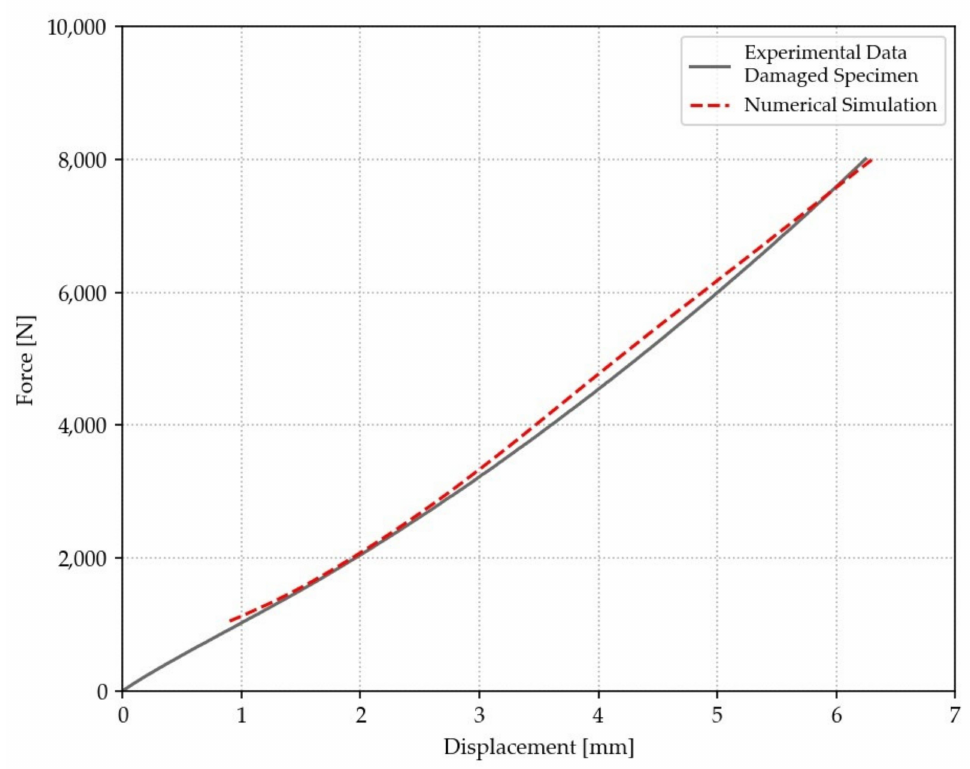
Figure 9. Comparison of experimental and numerical results of damaged